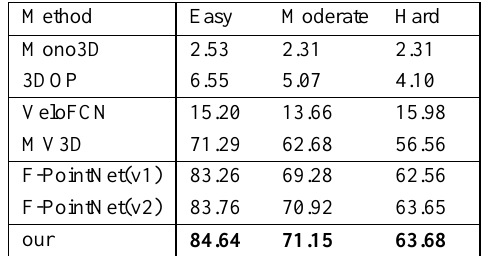
Table 2. 3D object detection AP on KITTI val set (cars